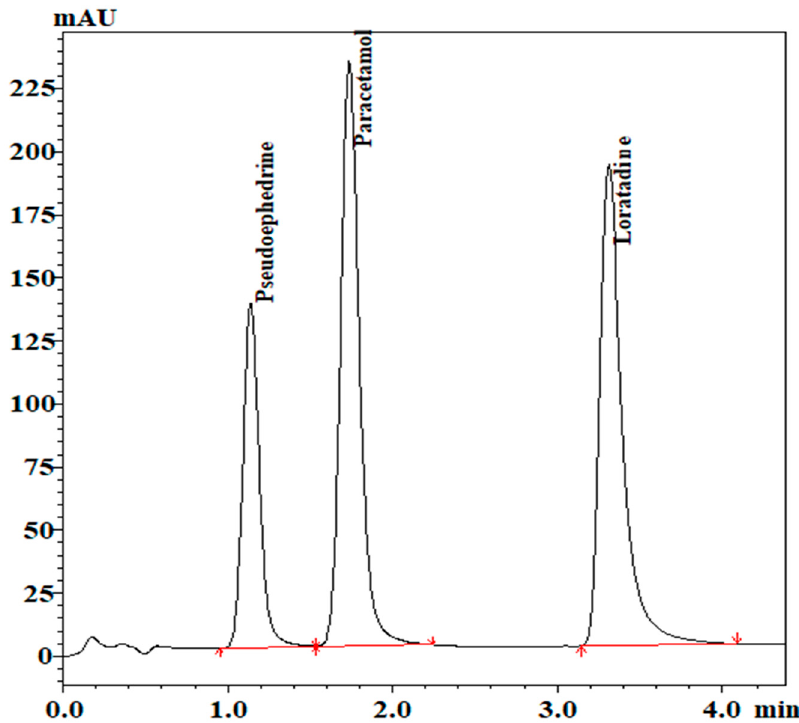
Figure 4. Chromatogram for full separation of the analytes using the gradient HPLC method. Table 2. System suitability parameters of the developed HPLC-PDA method .